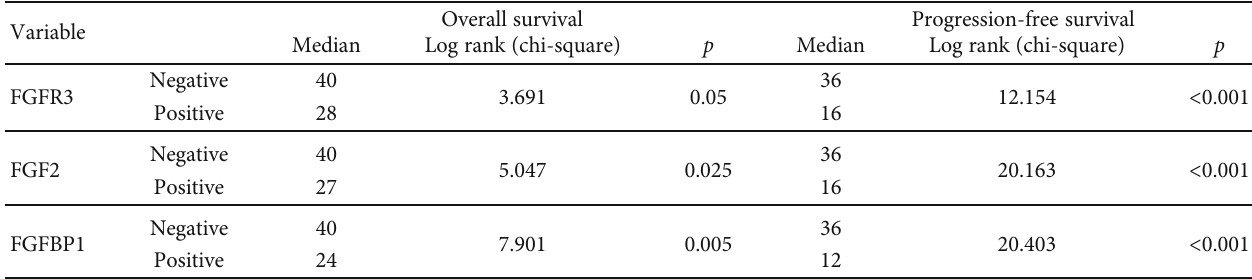
Table 7: Univariate analysis of overall and progression-free survival in patients with ESCC postoperative chemoradiotherapy.